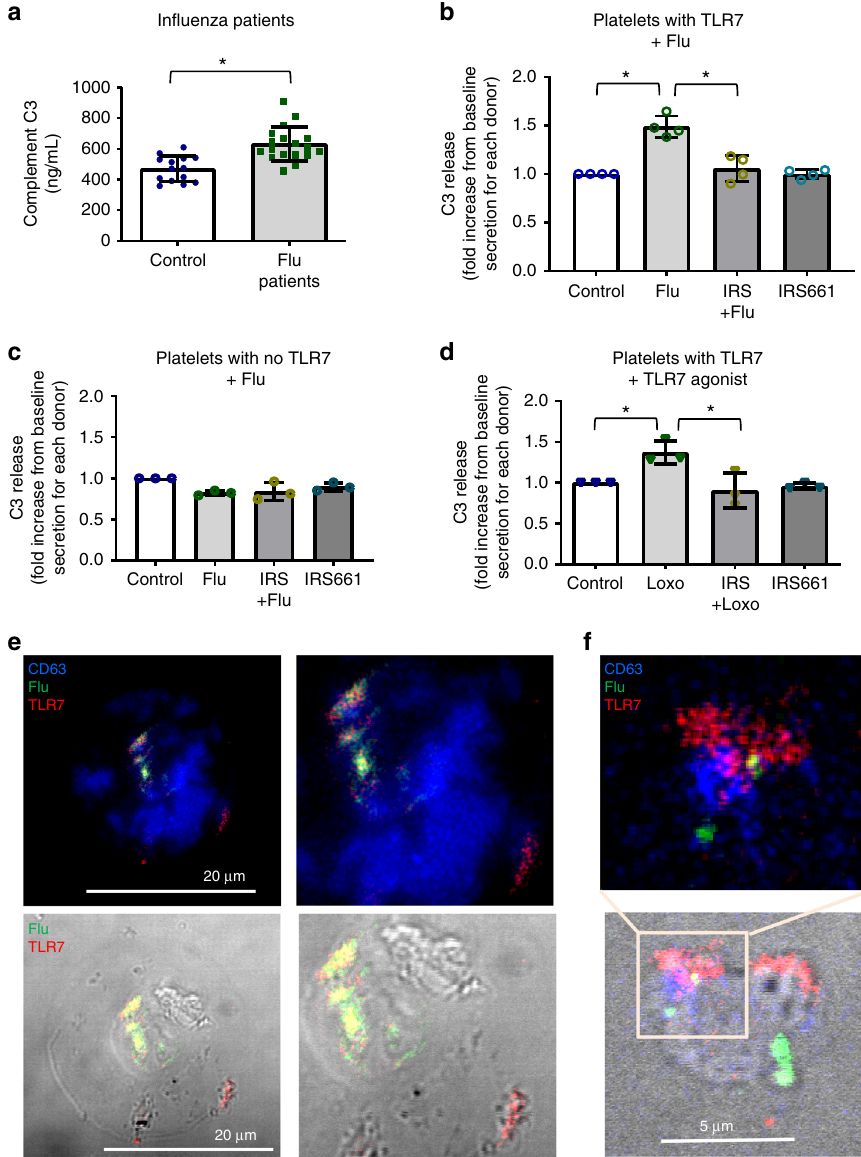
Fig. 5 In fl uenza mediates C3 release from platelets through TLR7. a C3 in plasma from healthy donors ( n = 14) and in fl uenza-infected patients ( n = 18). The graphs represent the average ± SD; signi fi cance was assessed by Mann – Whitney U test, * p < 0.0001. b C3 release from human platelets that express TLR7 (assessed by qPCR) had been isolated from healthy donors and mixed with in fl uenza strain WSN/33 at a proportion of 1 pfu to 100 platelets ( n = 4, 3F, 1M); p < 0.0001, F = 27.49, df = 3. c C3 release from human platelets that do not express TLR7 (assessed by qPCR) treated as in ( b ). Graph is representative of n = 3 different blood draws; p = 0.2813, F = 1.833, df = 3. d C3 release from human platelets from the same donors as in ( b ) treated with the TLR7 agonist loxoribine 1 mM in the presence or absence of TLR7 inhibitor IRS661; p = 0.0086, F = 7.989, df = 3. b – d Data in graphs are represented as average ± SD; signi fi cance was assessed using ANOVA followed by Bonferroni multiple comparison test and star symbol (*) indicates p < 0.05. Source data for ( a – d ) are provided as a Source Data fi le. e Confocal images of permeabilized isolated platelets from in fl uenza-infected patient stained for fl u-FITC; TLR7-APC; lysosomal marker CD63-BV421. f Confocal images of isolated healthy human platelets incubated with WSN/33 for 30 min (1 pfu to 10 platelets) and stained as in ( e ). e , f Representative images of platelets from n = 4 (2M, 2F) different donors are